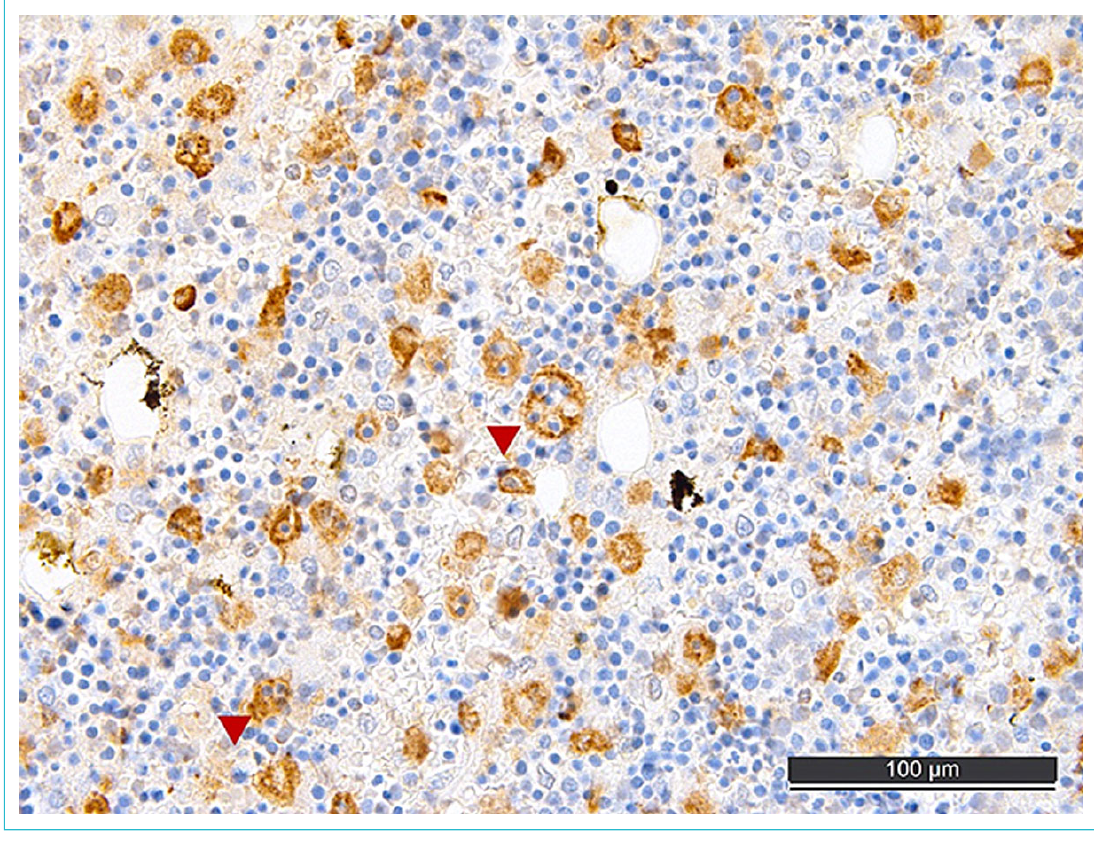
Figure 2: CD68-stained post mortem bone marrow with increased histiocytes, some with phagocytosed erythrocytes (arrowheads), consistent with haemophagocytic